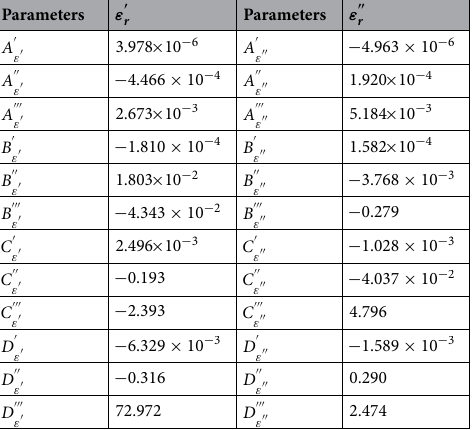
Table 1. Parameters to obtain the real ( ε to the sucrose concentration used.